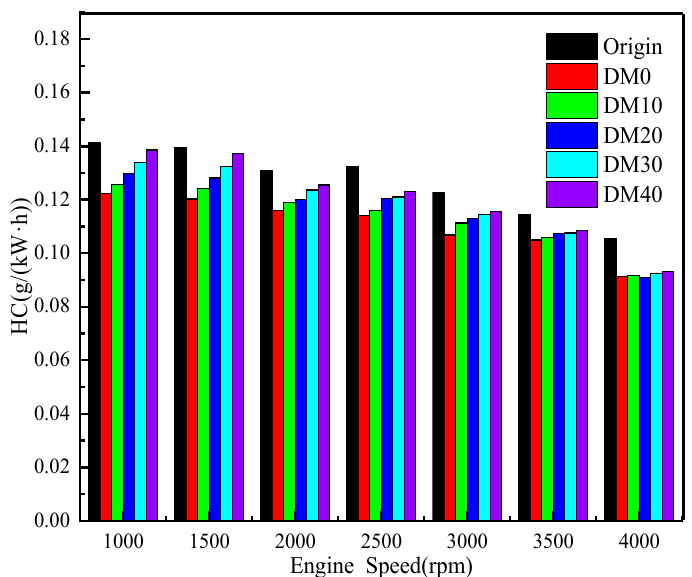
Figure 12. Effect of different ratios of methanol-diesel mixtures on HC emission at different speeds.